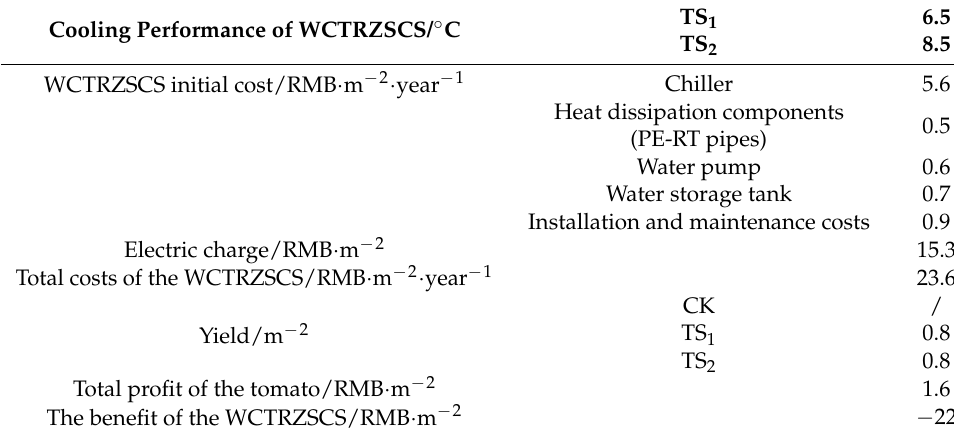
Table 8. Economic assessment of